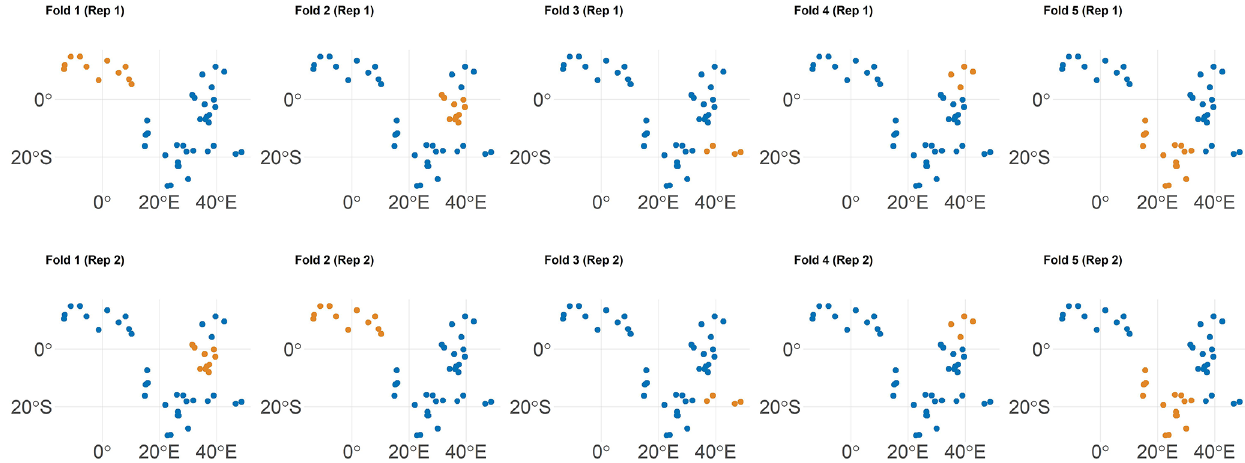
Figure A4. Spatial visualization of selected training (blue) and test (orange) observations for spatial cross-validation of two repetitions from the topsoil samples. Note: each dot may represent multiple